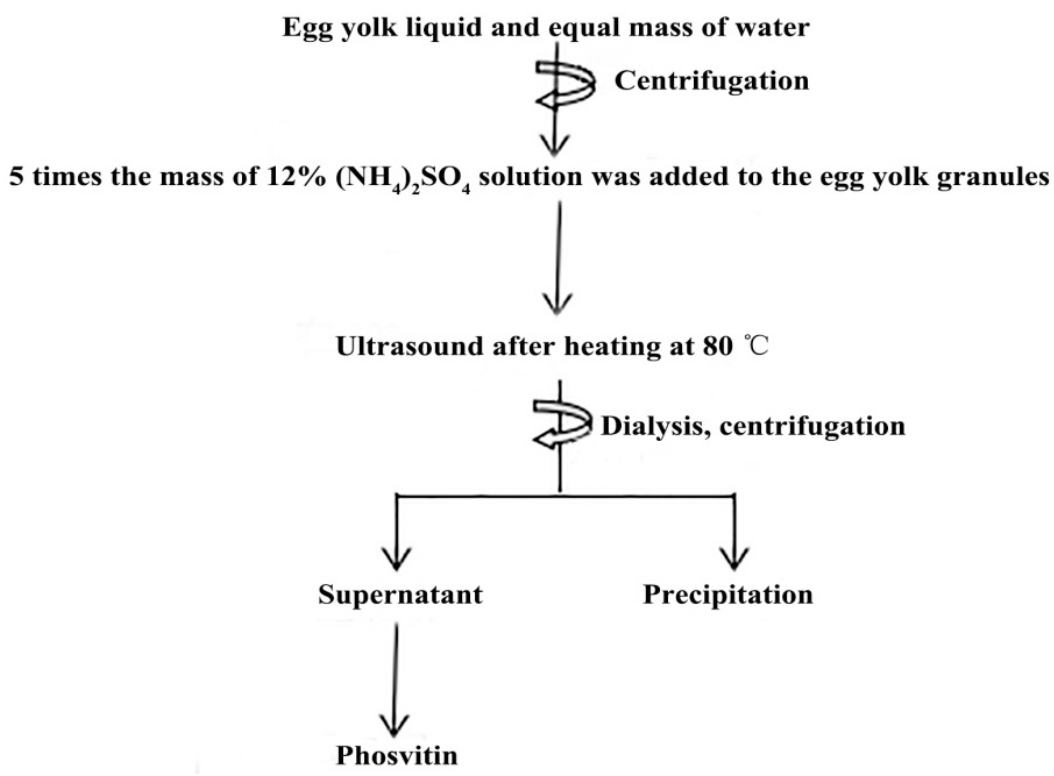
Figure 1. Isolation procedure of Pv.